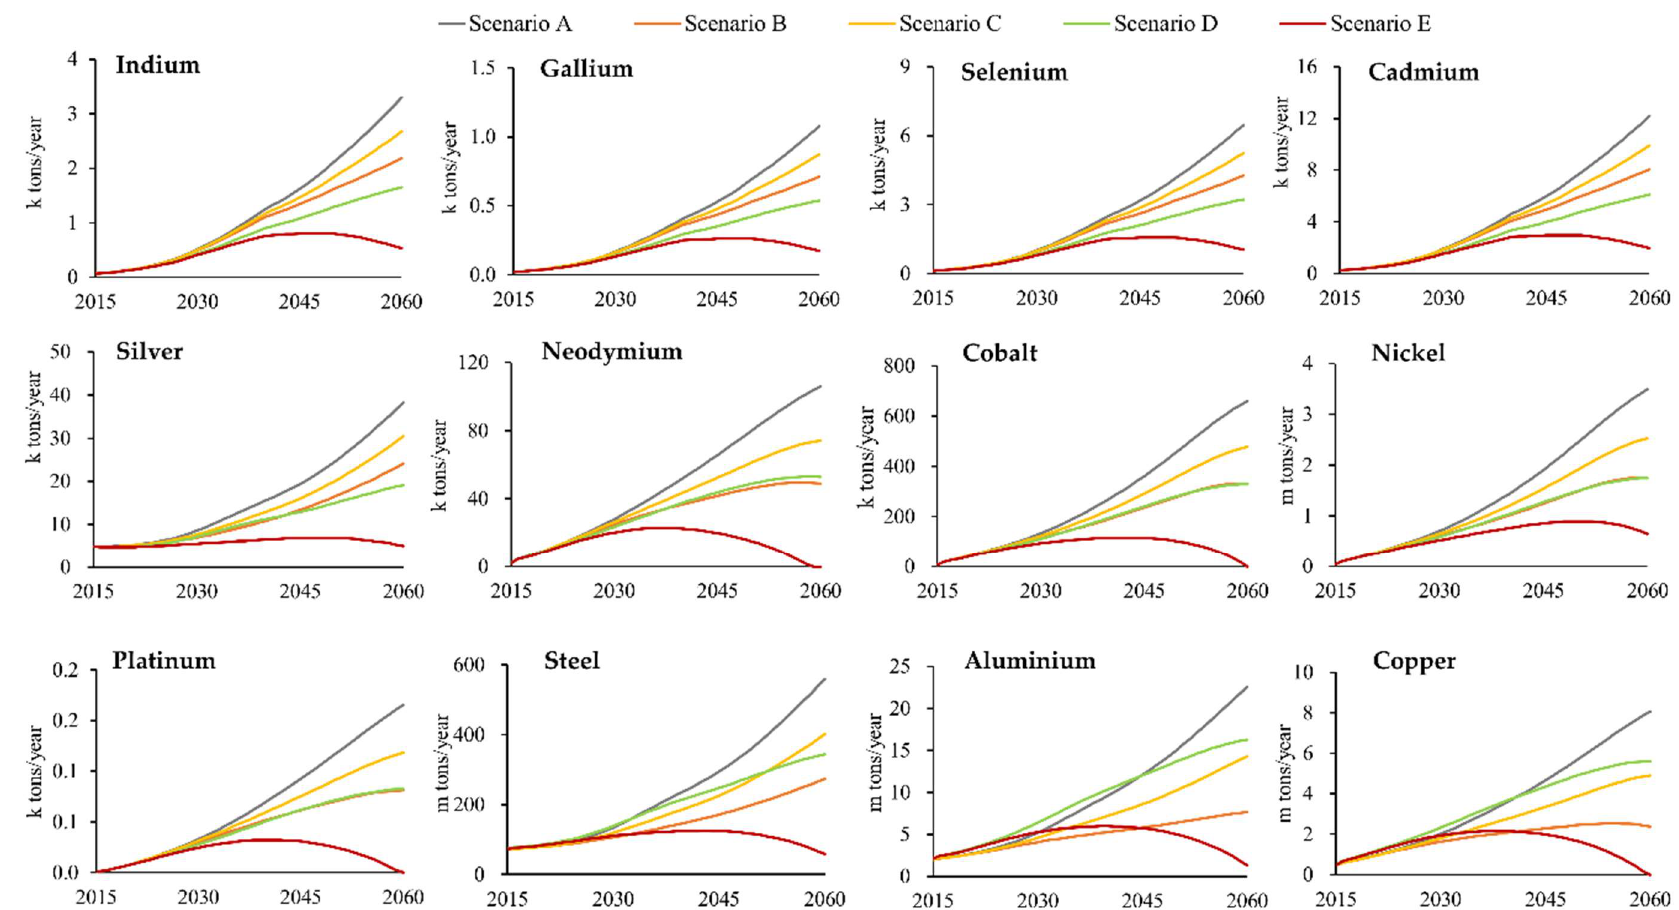
Figure A4. Complete Annual demand for low carbon energy technology considering recycling and reducing (except Te, Dy, Li).